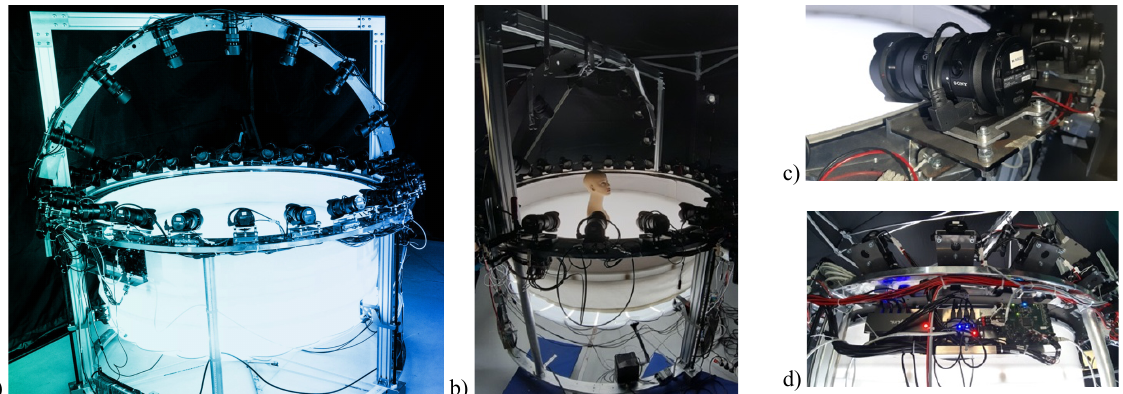
Figure 1: The DI-One multi-camera system with 31 PCB synchronized cameras, lights and a moving basement (a, b). One of the high-end professional cameras (c) and the electronics used to control groups of cameras